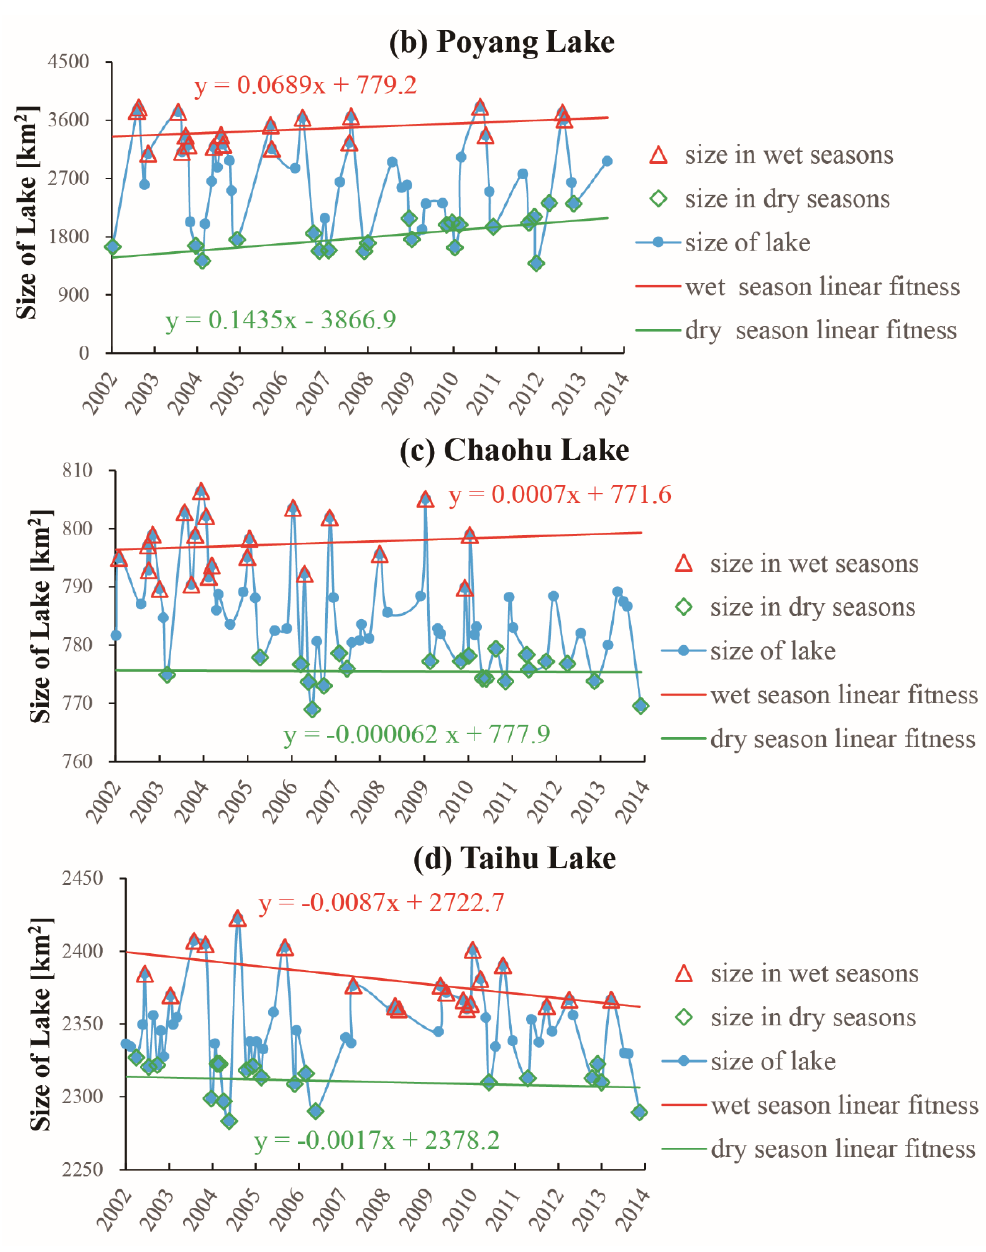
Figure 3. Seasonal sizes of four Yangtze River lakes from 2002 to 2013 for ( a ) Dongting Lake; ( b ) Poyang Lake; ( c ) Chaohu Lake, and ( d ) Taihu